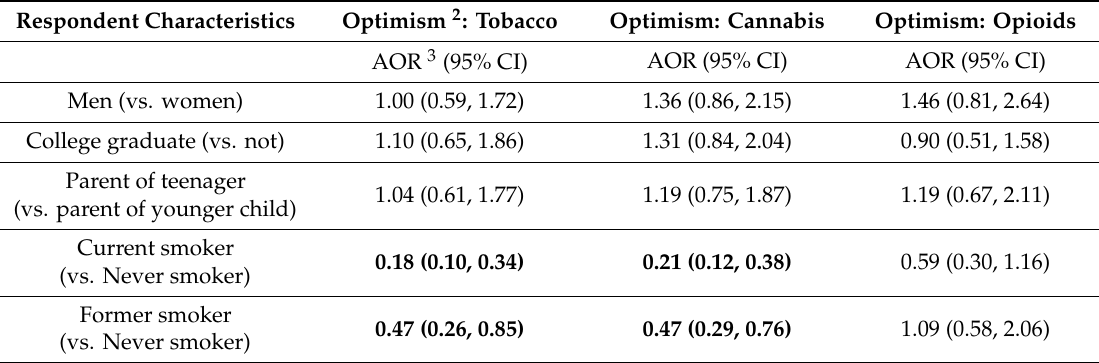
Table 2. Parental likelihood of being optimistic over their child’s use of tobacco, cannabis, and opioids before age 18 ( n = 400) 1 .